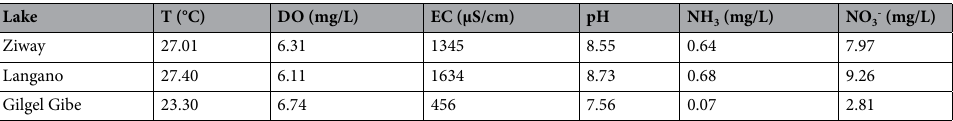
Table 1. Physicochemical properties of the three Ethiopian lakes in this study. (In situ measurement); T = Temperature, DO = Dissolved oxygen, EC = electric conductivity.